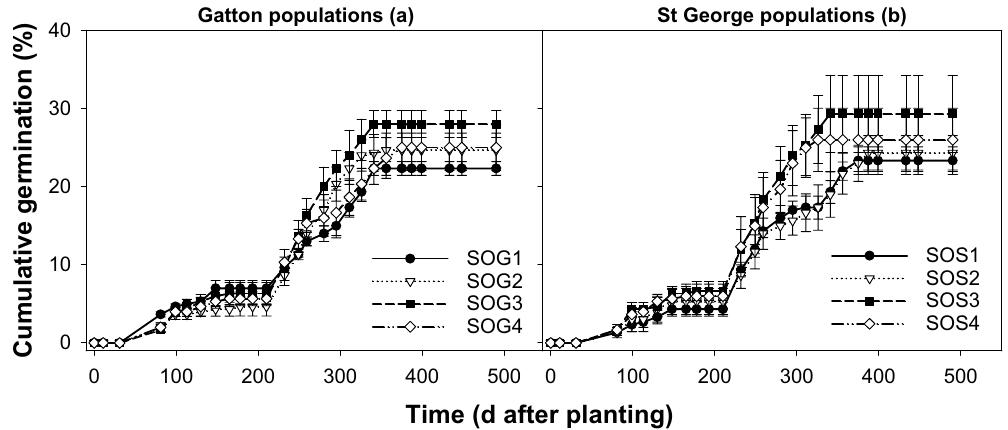
Figure 4. Emergence pattern of Sonchus oleraceous populations from Gatton (SOG1-SOG4; a) and St George (SOS1-SOS4; b) in trays under a rainfed environment (November 2015 to April 2017), symbols correspond to mean and error bars are the standard error of means (n = 3).